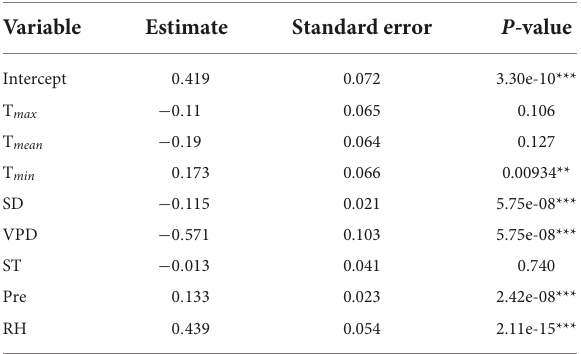
TABLE 2 The standardized regression coefficient estimated from linear mixed-effects models.